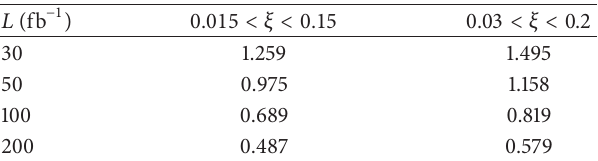
Table2:95%CLboundsontheanomalouscoupling 𝑔 𝑡𝑞𝐻 forvarious forward detector acceptances and integrated LHC luminosities. The center of mass energy of the proton-proton system is taken to be √𝑠 = 14